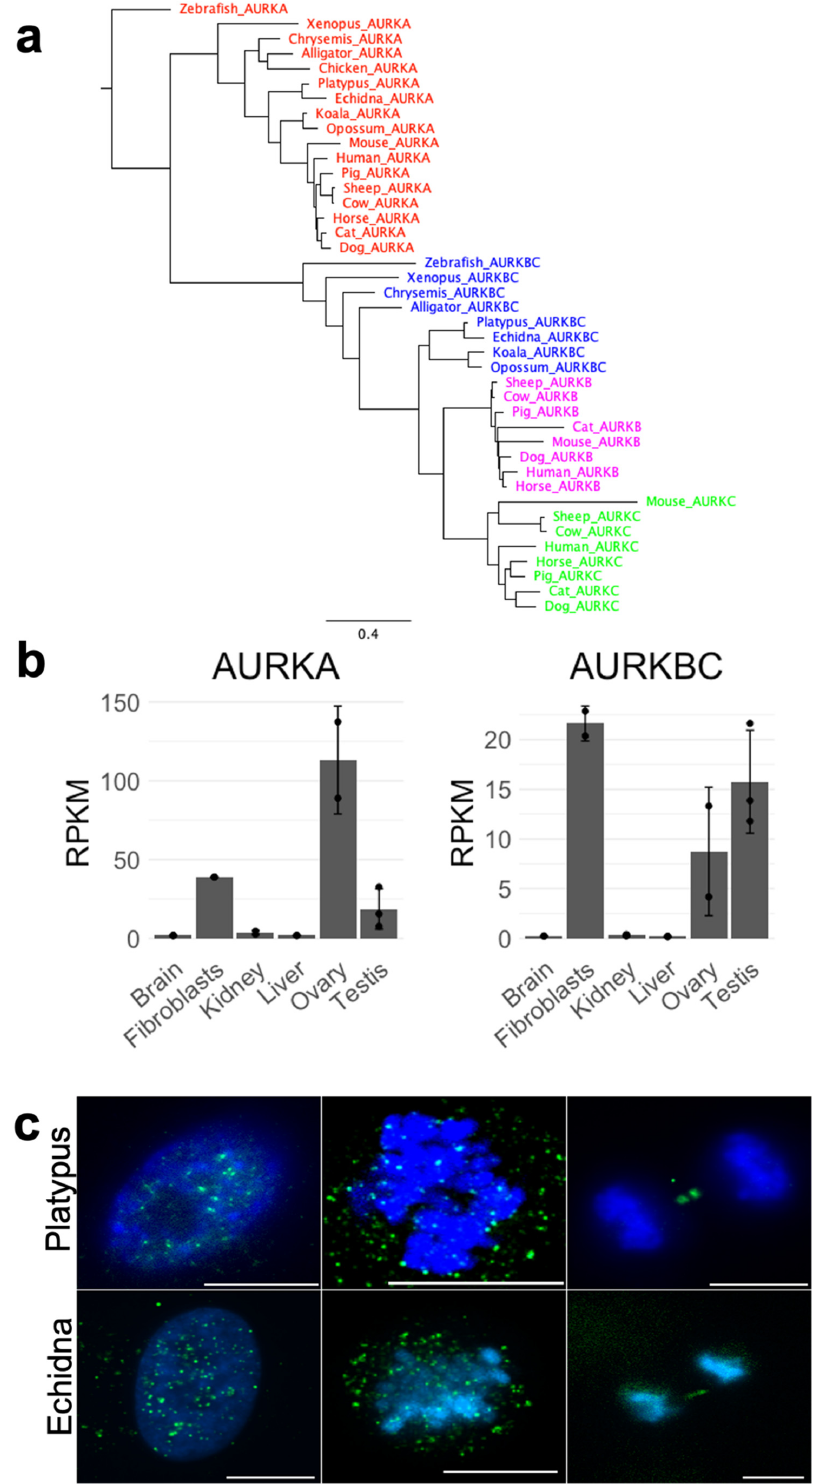
Figure 4. ( a ) Phylogenetic tree showing clustering of individual AURKs—AURKAs, AURKBCs (the ancestral version before AURKC emerged), AURKBs (therian mammals), and AURKCs (placental mammals only) cluster together, respectively. ( b ) The expression profile of platypus AURKA and AURKBC. ( c ) Immunofluorescence of platypus and echidna AURKBC in cultured fibroblasts, showing a similar localization to other mammals at mitosis (scattered interphase pattern, metaphase with predominant chromatin localization, and midbody-specific signal at anaphase, from left to right, respectively). Green signal—AURKBC, blue signal—DAPI. Scale bar—10 µ